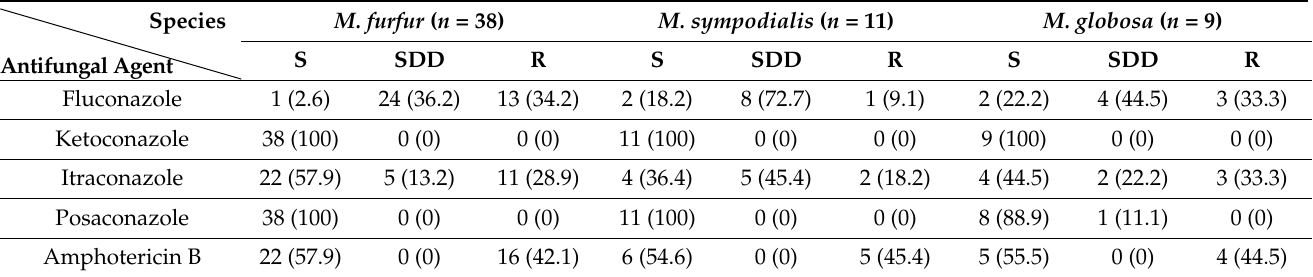
* The difference is statistically significant with p value < 0.05. Table 4. Interpretive antifungal susceptibility classification of Malassezia species according to the species into susceptible (S), susceptible dose-dependent (SDD), and resistant (R): number of isolates (and percentage) by